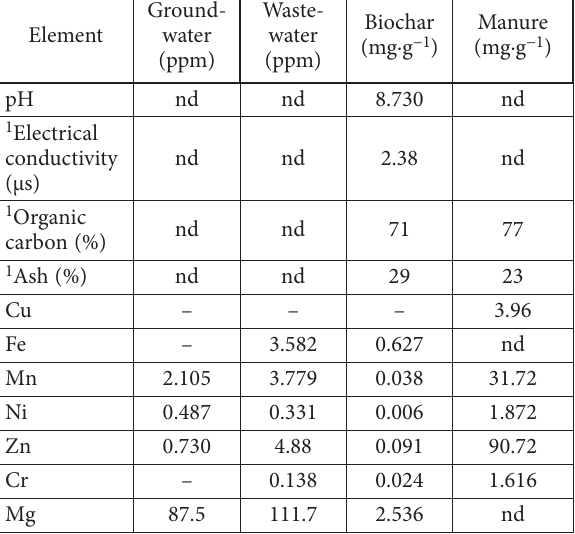
were separated, soil from the roots was removed with wa- ter, the biomass was oven-dried at 60 °C for 48 hours and dry biomass was measured.